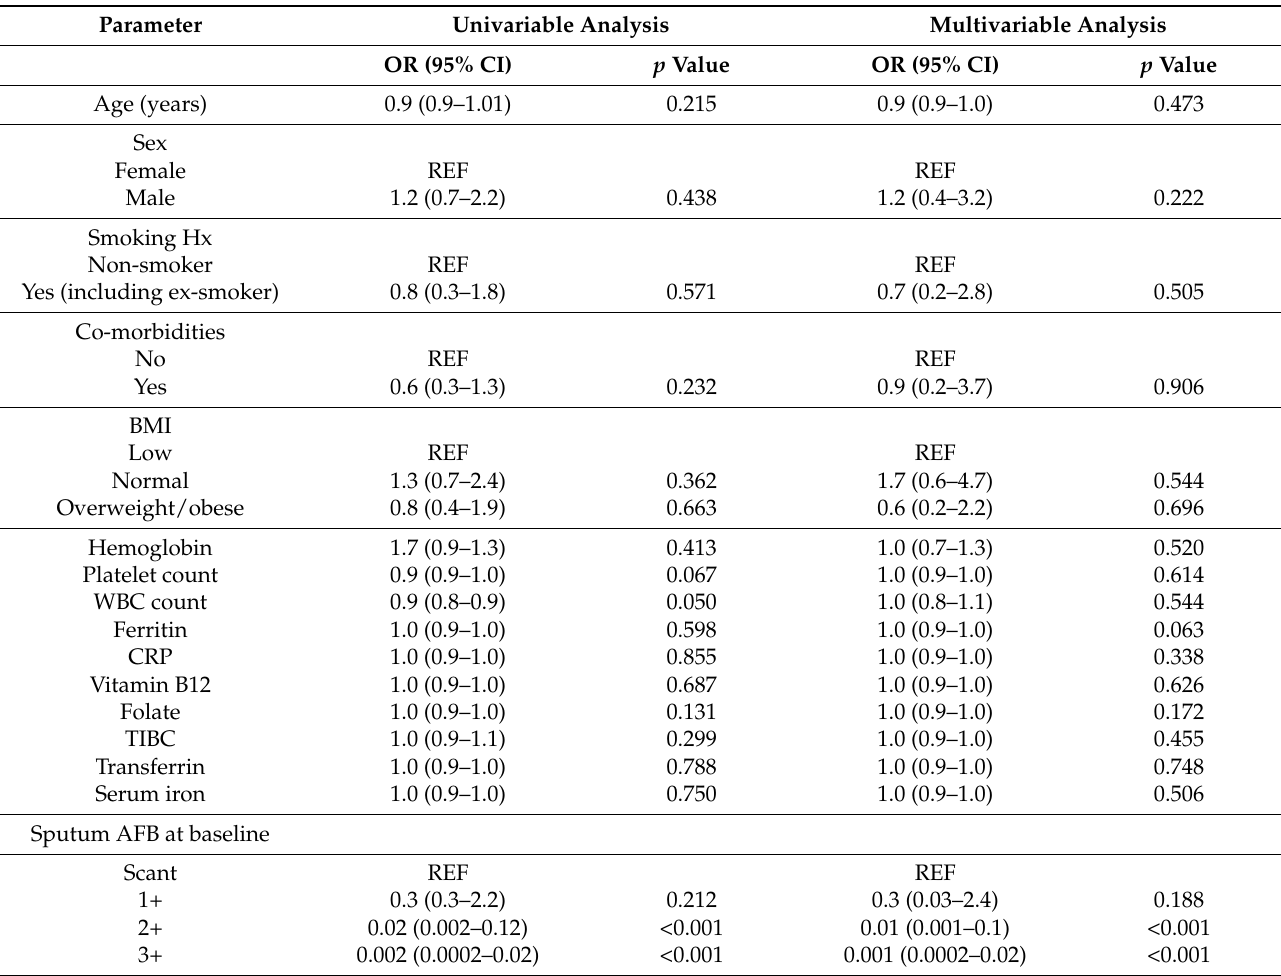
Table 3. Multivariate regression analysis for association of demographic, anthropometric, and laboratory variables with early or late response ( n =